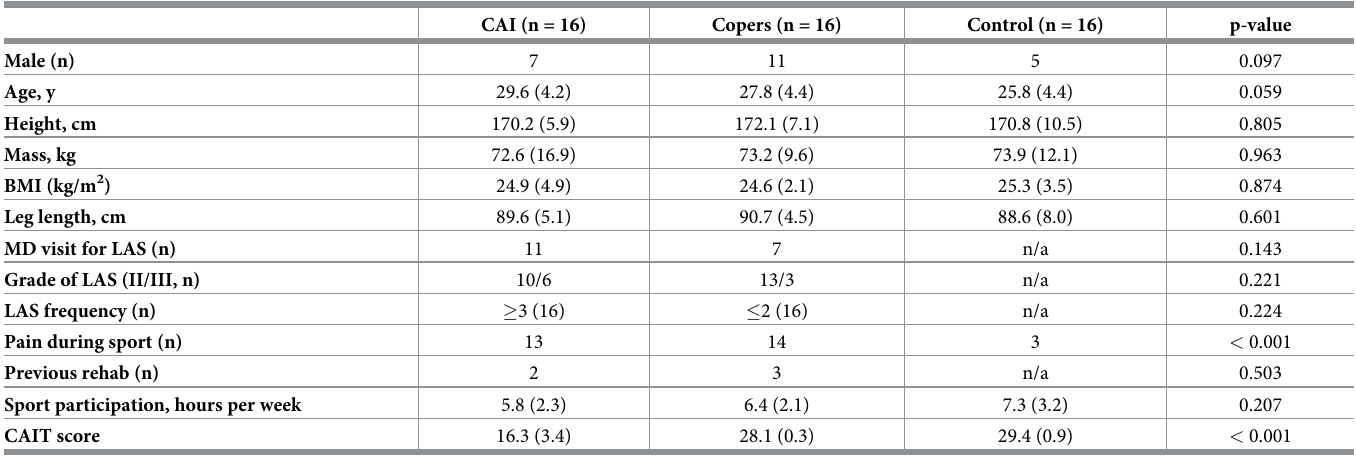
Table 1. Mean (SD) of baseline characteristics by study group (N = 48).